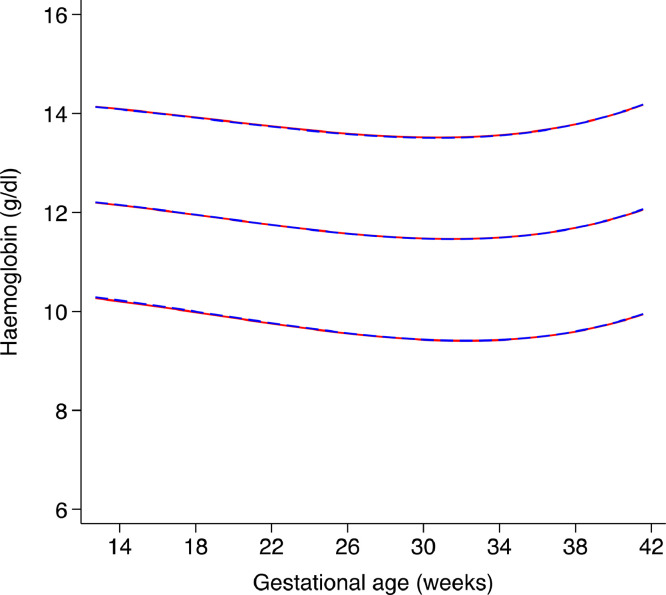
represents sensitivity analyses showing the smoothed, gestational age-specific, 3rd (red), 50th (red) and 97th (red) centiles for maternal haemoglobin from the total Fetal Growth Longitudinal Study pooled sample (n = 3502) and the fitted 3rd (blue), 50th (blue), and 97th (blue) centiles after excluding women who delivered preterm (n = 3364). (For interpretation of the references to color in this figure legend, the reader is referred to the web version of this article.)